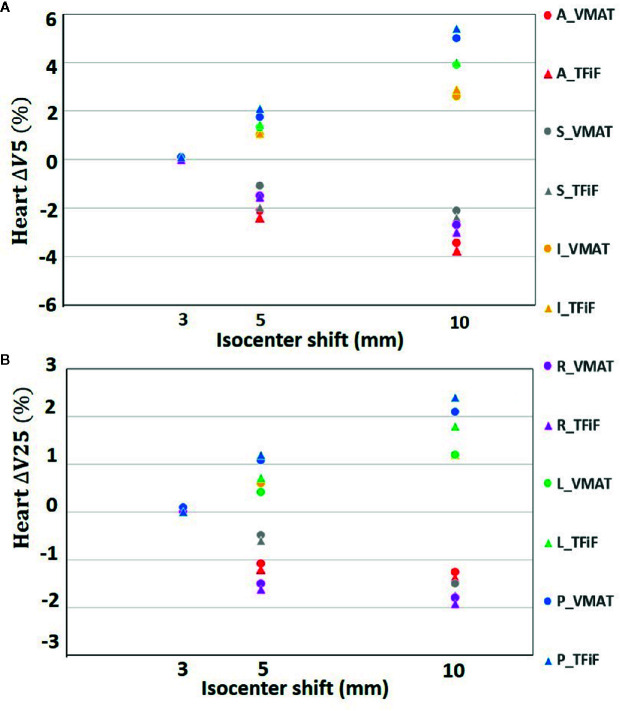
Heart V5
(A) and V25
(B) absolute differences between VMAT and TFiF references and corresponding perturbed plans, for different isocenter shifts directions and magnitudes. VMAT, volumetric modulated arc therapy; TFiF, tangential field in field; A, anterior; P, posterior; I, inferior; S, superior; R, right; L, left.